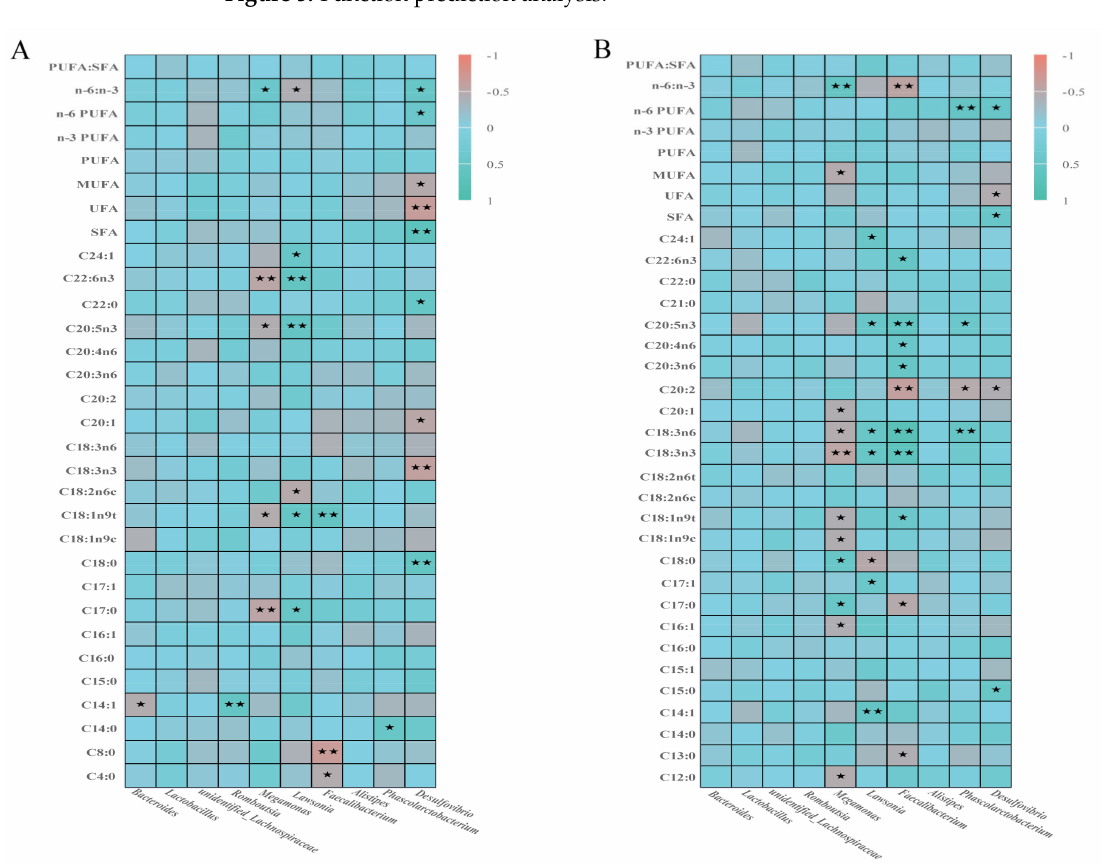
Figure 6. Spearman correlation analysis of caecal microorganisms and muscle fatty acids at genus level. Note: ( A ) Correlation analysis between pectoral muscle fatty acids and cecal microor- ganisms; ( B ) Correlation analysis between fatty acids of leg muscle and cecal microorganisms. * indicates p < 0.05; ** indicates p <